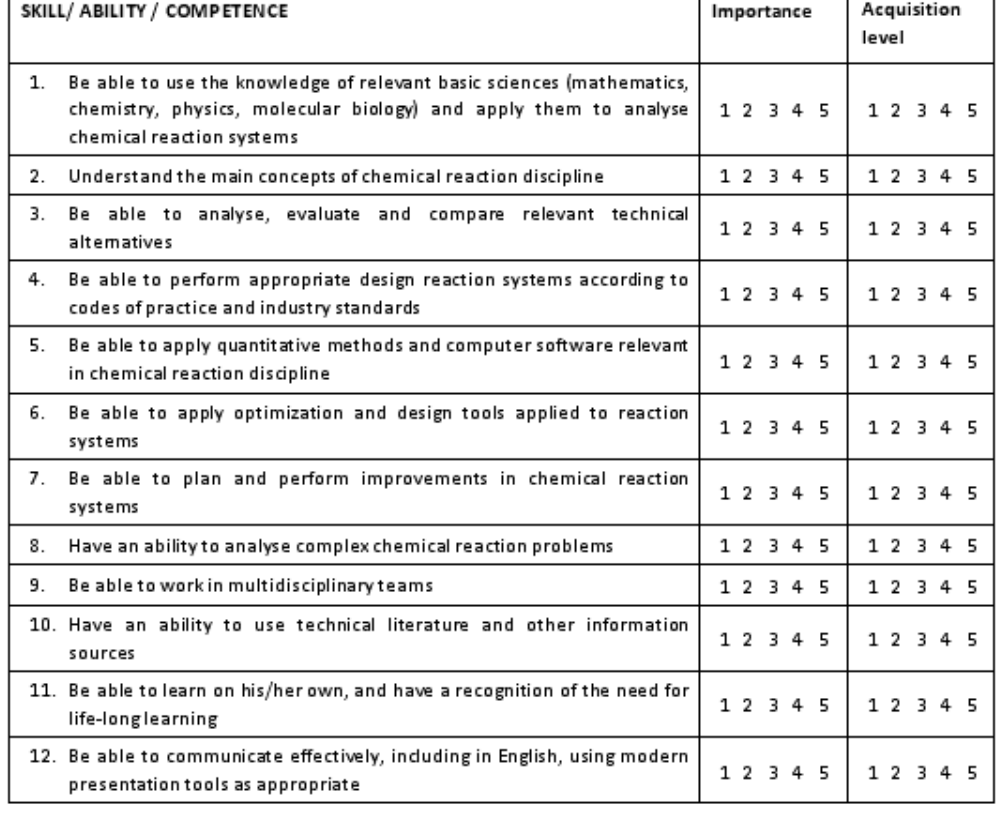
Fig 2. Skill evaluation questionnaire of the Chemical Reactors